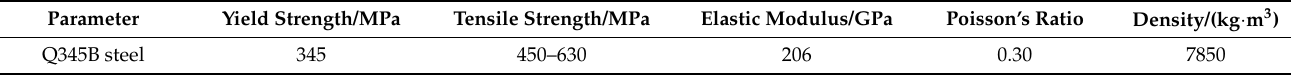
Table 2. The mechanical property parameter of Q345B